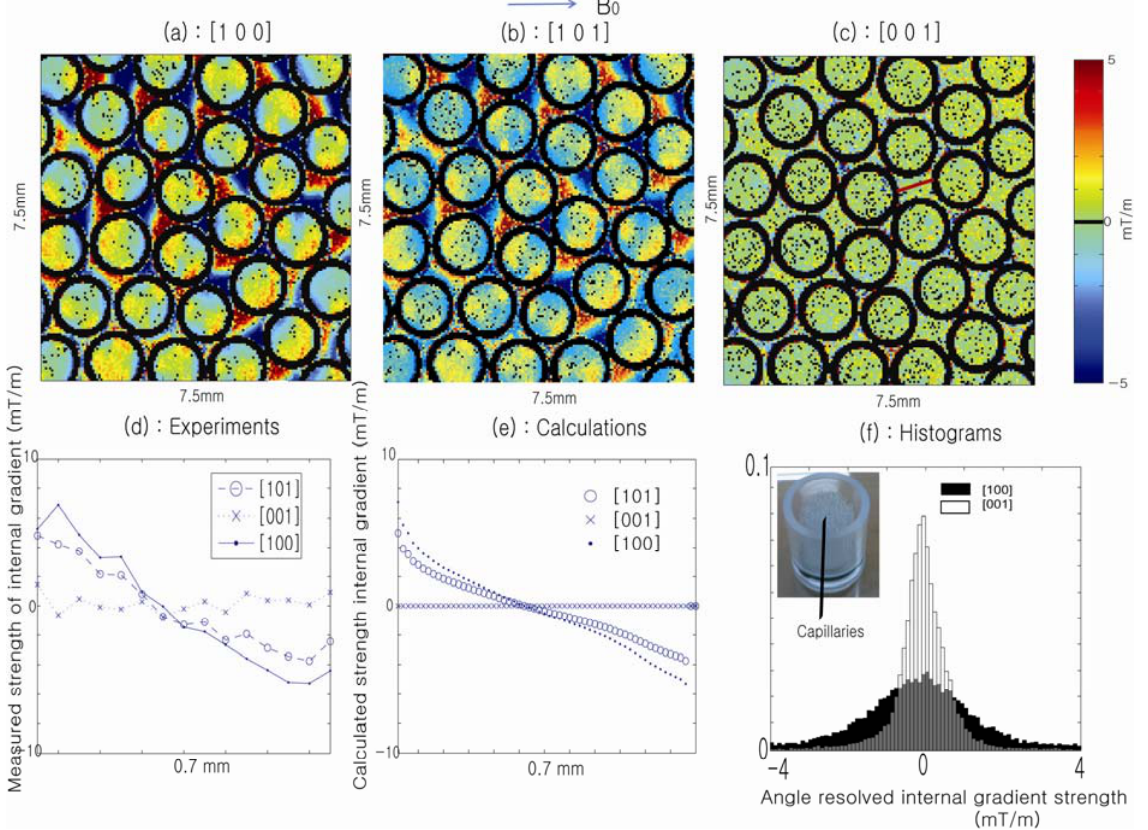
Figure 7. In the top panel, sections ( a – c ) show spatial maps of the DDIF cross-term rates, respectively, when external pulsed-field gradient (PFG) is applied along different directions. In the bottom panel, sections ( d ) and ( e ) compare the internal gradient strength across the pore denoted in ( c ) determined from experimental DDIF rates with that derived from theoretical calculations. ( f ) Histogram distribution of the measured internal gradient strengths along the [100] and [001] directions, respectively. Reproduced from Reference [43] with